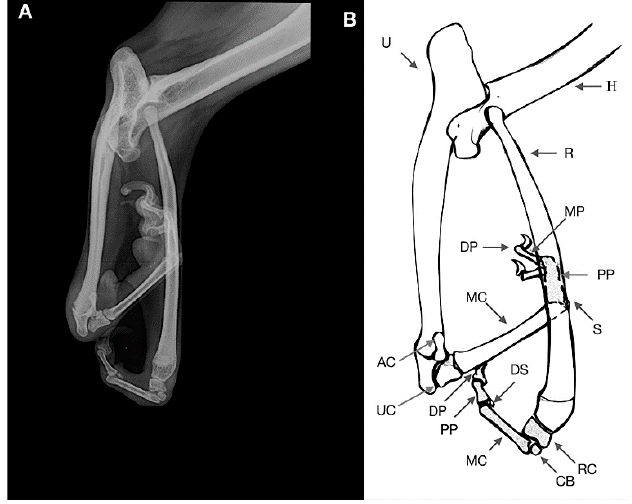
Figure 6. Case 2. Mediolateral radiograph ( A ) and drawing scheme ( B ) of the right forelimb malformation. R: Radius; U: Ulna; H: Humerus; RC: Radial Carpal Bone; UC: Ulnar Carpal Bone; AC: Accessory Bone; CB: Carpal Bone; MC: Metacarpal Bone; PP: Proximal Phalange; MP: Middle Phalange; DP: Distal Phalange; DS: Dorsal Sesamoid. Arrows indicate the “stubby bone” resulting by the fusion of the two proximal phalanges.